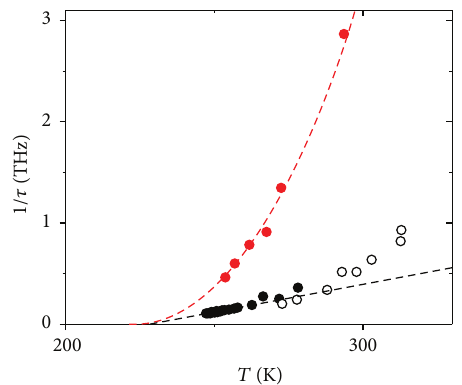
Figure 21: The relaxation frequency 1/𝜏 of water measured in [7] (black dots) and [34] (open dots) are reported along with the linear best fit of supercooled phase data (black dashed line). Results obtained by OKE methods [8] are also reported for comparison (red dots) along with the critical law best fitting them (red dashed